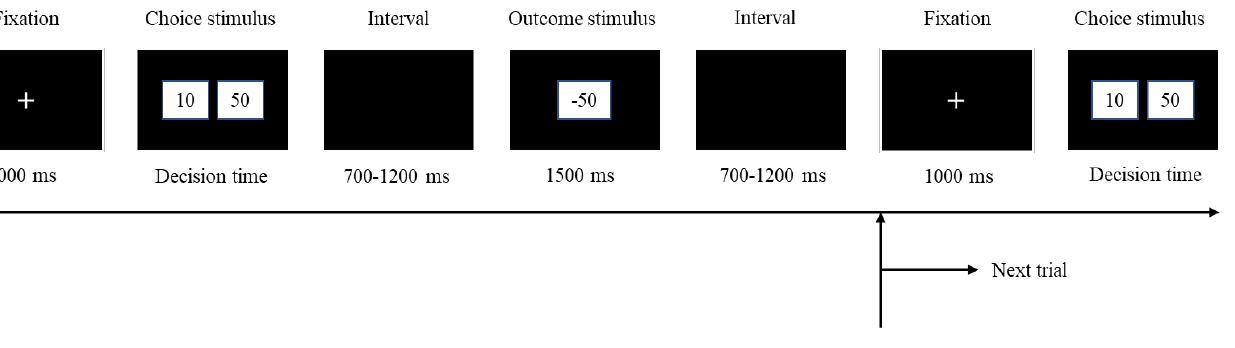
Figure 1. Single outcome gambling task.